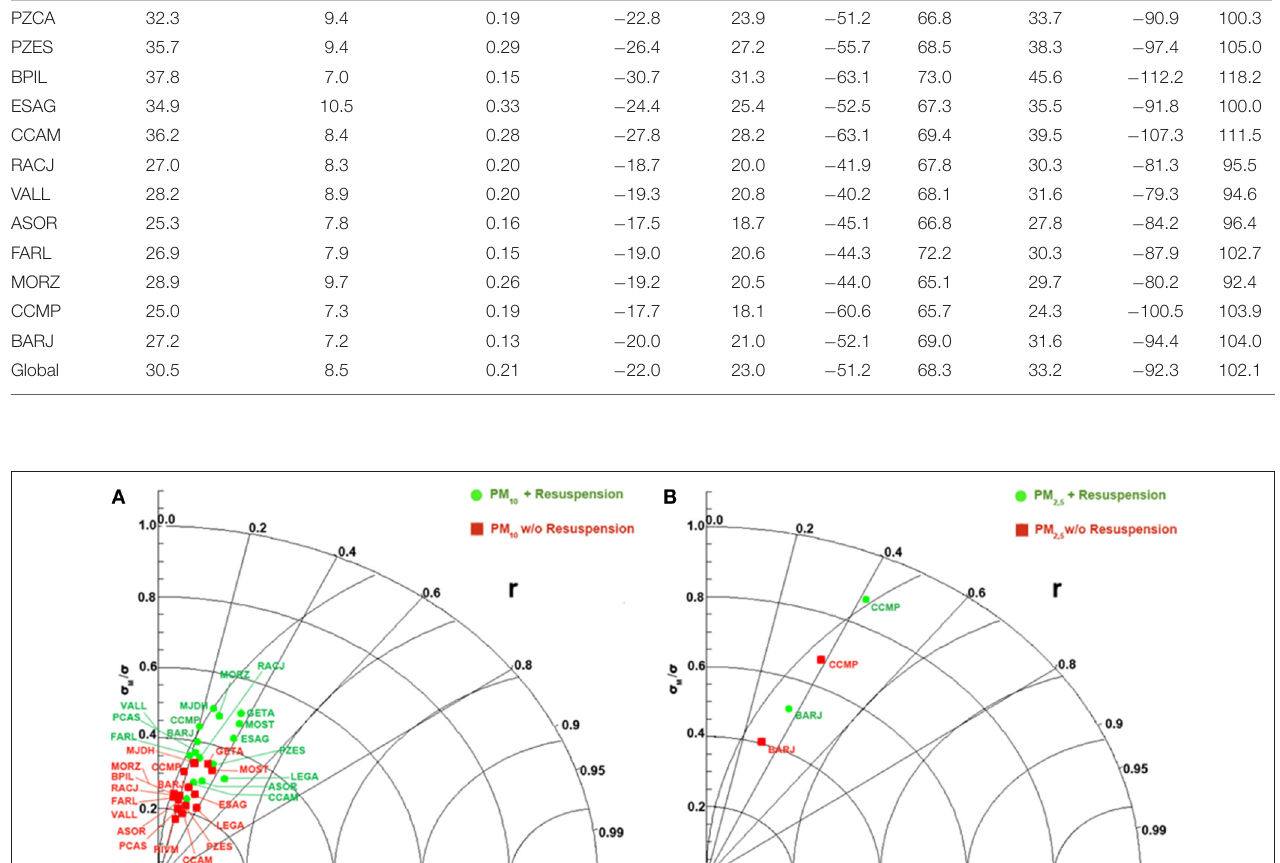
Frontiers in Environmental Science |